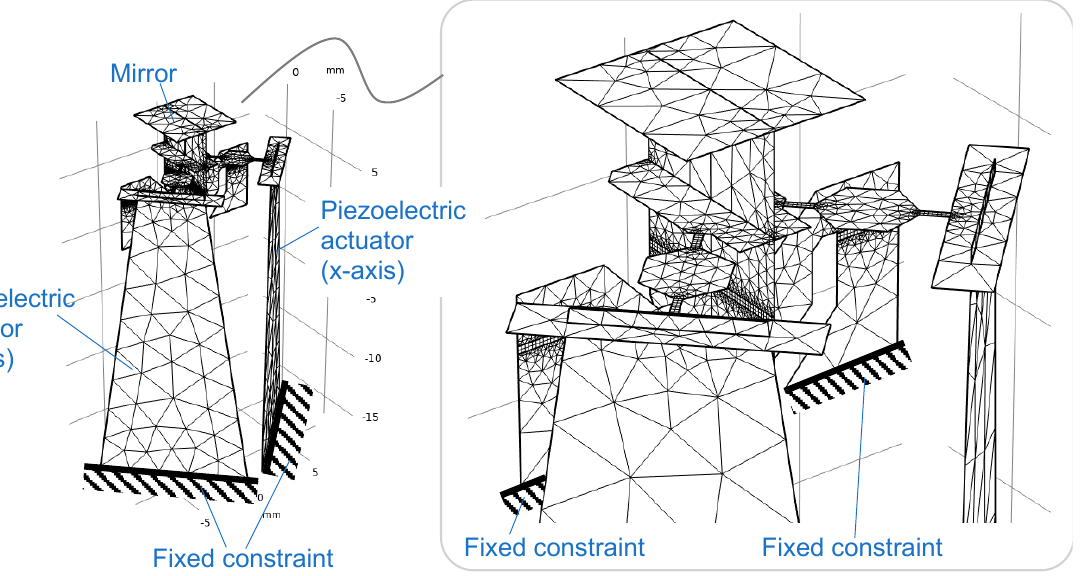
Figure 5. FEA model for resonant mode and static actuation angle.